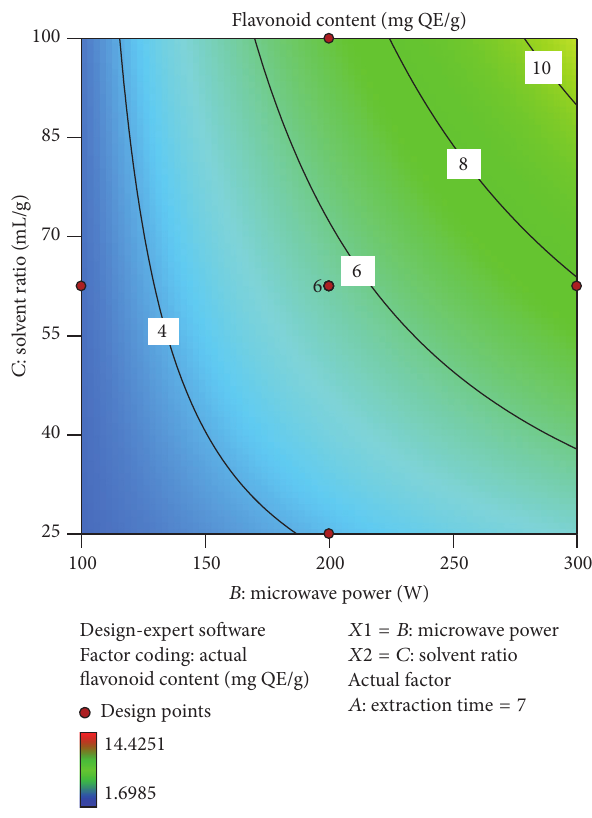
Figure 7: Response surface plot of the interaction between microwave power ( 𝐵 ) and solvent/solid ratio ( 𝐶 ) on the total flavonoid content of roselle